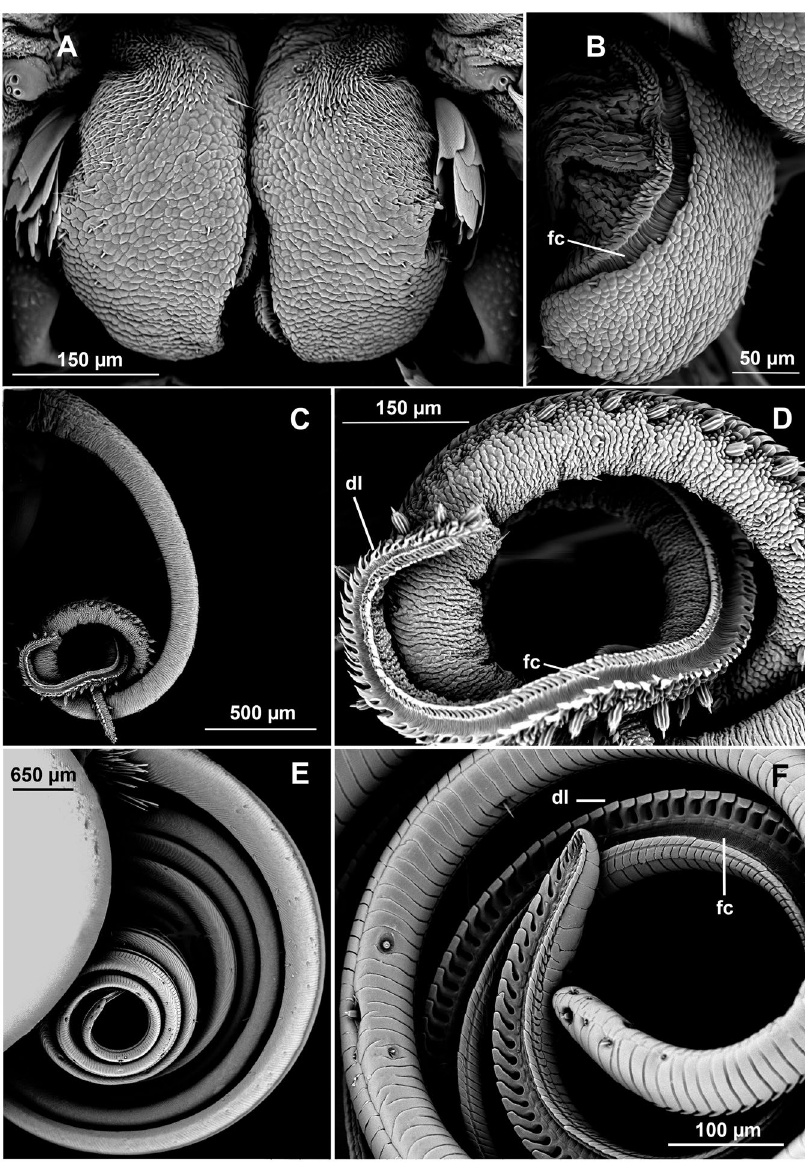
Figure 2. Scanning electron micrographs of moth proboscises representing various lengths: short, intermediate, and long. ( A , B ) Symmerista albifrons , anterior and medial views, respectively. ( C , D ) Nadata gibosa , lateral and apicolateral views, respectively, ( E , F ) Manduca sexta , lateral and apicolateral views, respectively. In ( C – F ), the galeae have been separated apically to show the food canal (fc) and dorsal legulae